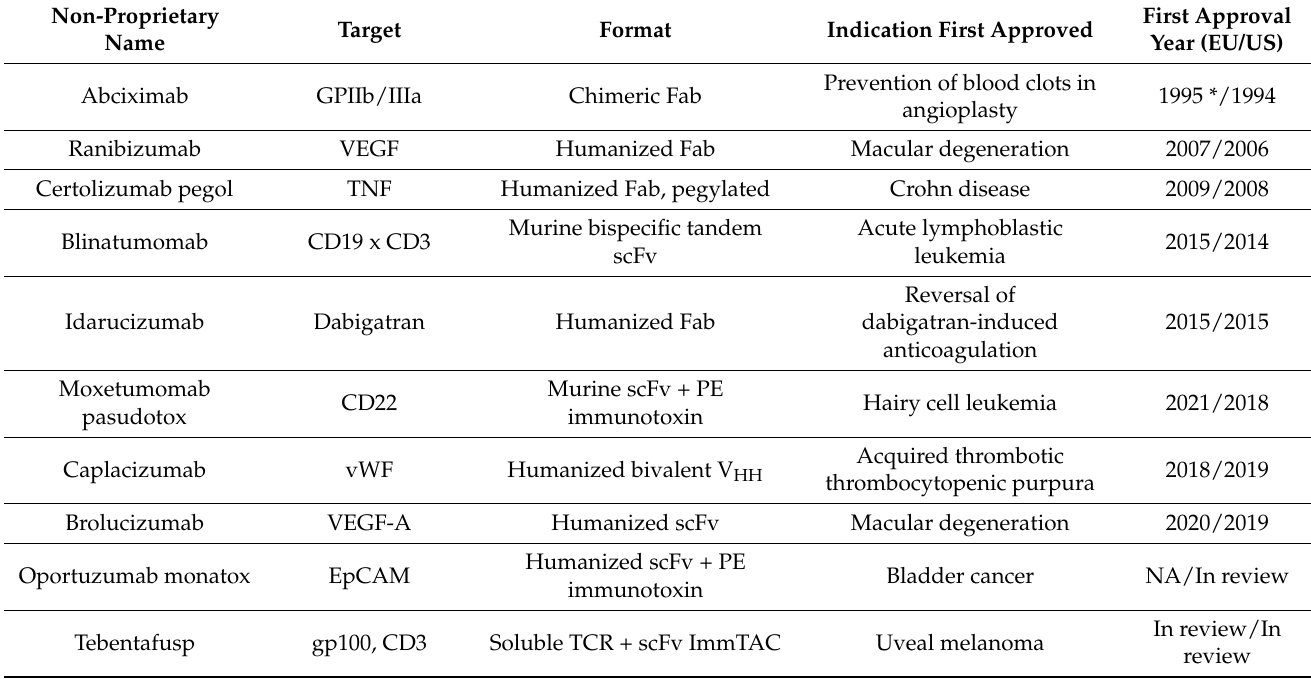
Table 1. Fc-free antibody-based therapeutics approved or in review (EU/US).